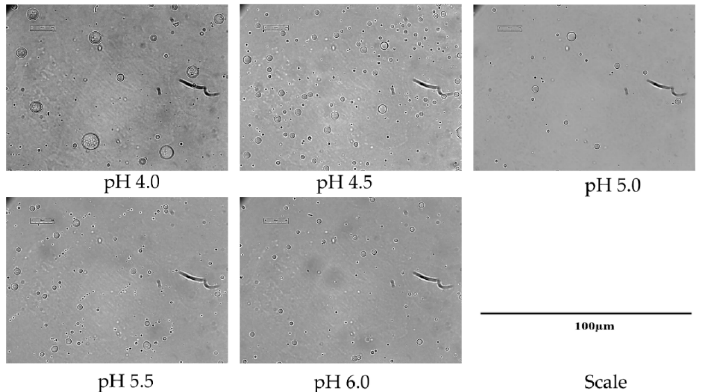
Figure 3. CH‐based droplets (Emulsion‐1) at different pH. Figure 3. CH-based droplets (Emulsion-1) at different